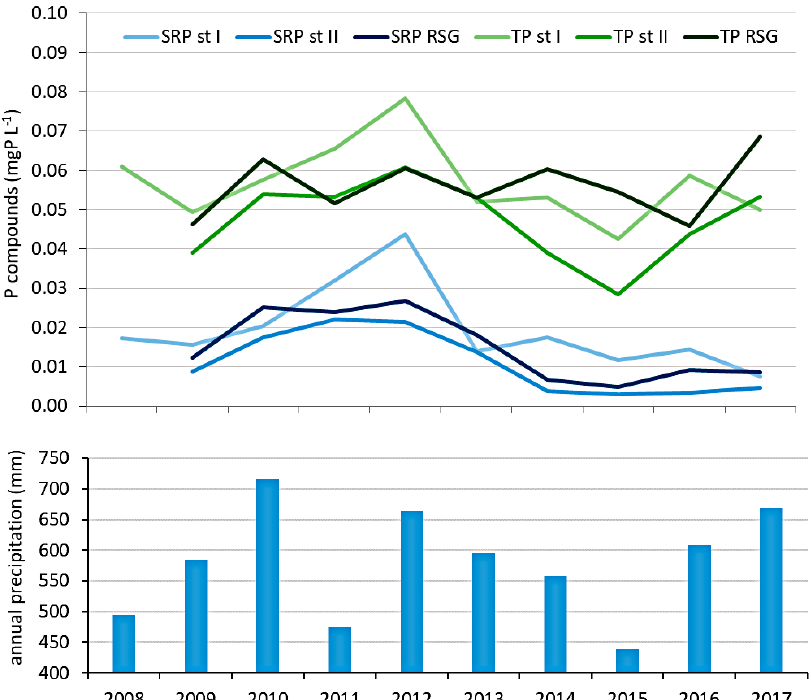
Figure 12. The dependence of SRP and TP concentrations in lake water at both stations on the content in River Struga Gołaniecka (RSG) and annual precipitation.